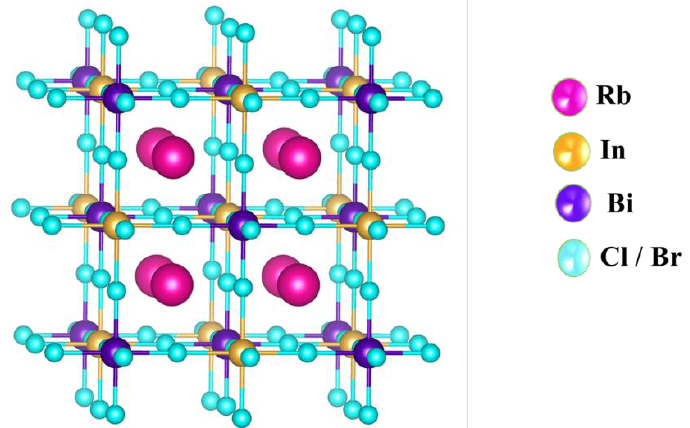
Figure 1. Generated cubic crystal structure of Rb 2 InBiX 6 (X = Cl, Br) compounds.